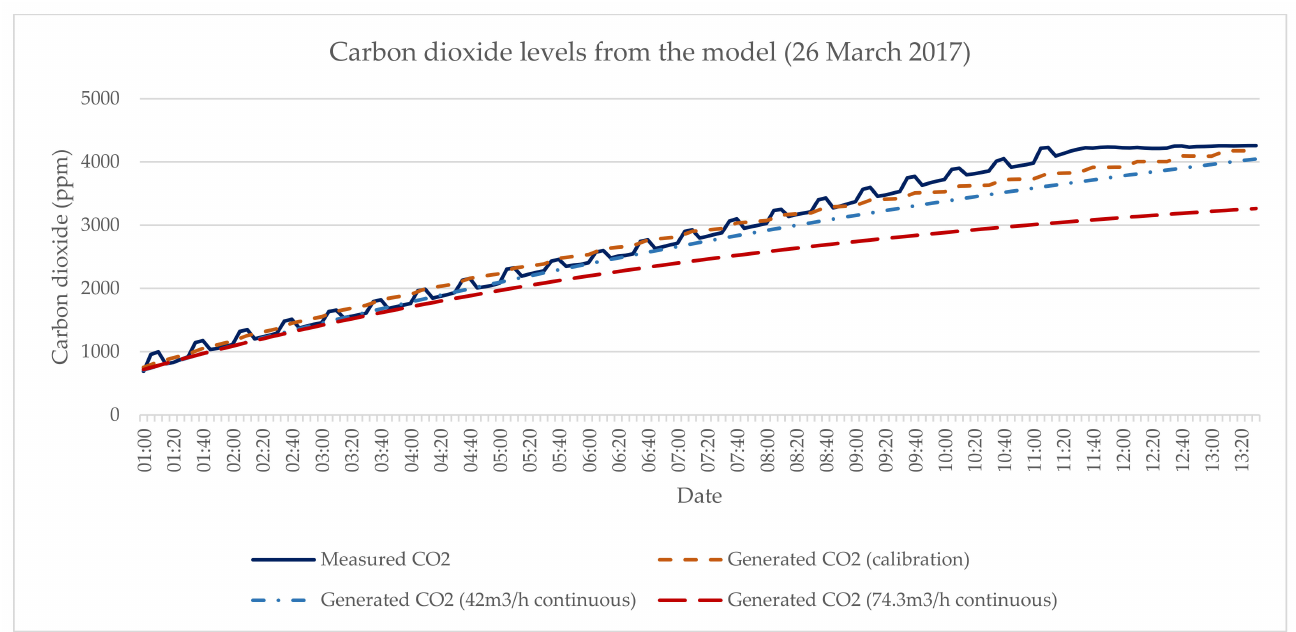
Figure 3. Measured and modelled overnight CO 2 levels. Source: Authors.